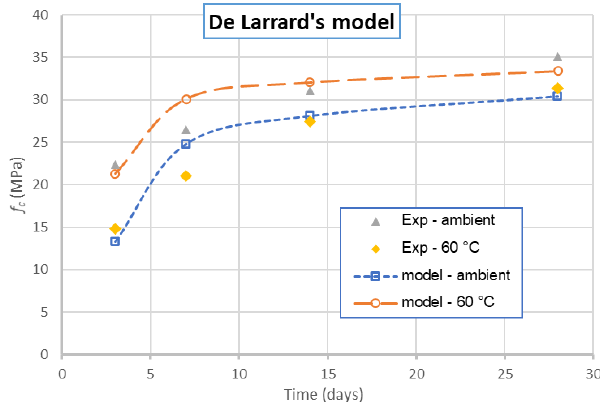
Figure 23. Comparison of numerical and experimental results of GRAC compressive strength at different ages.